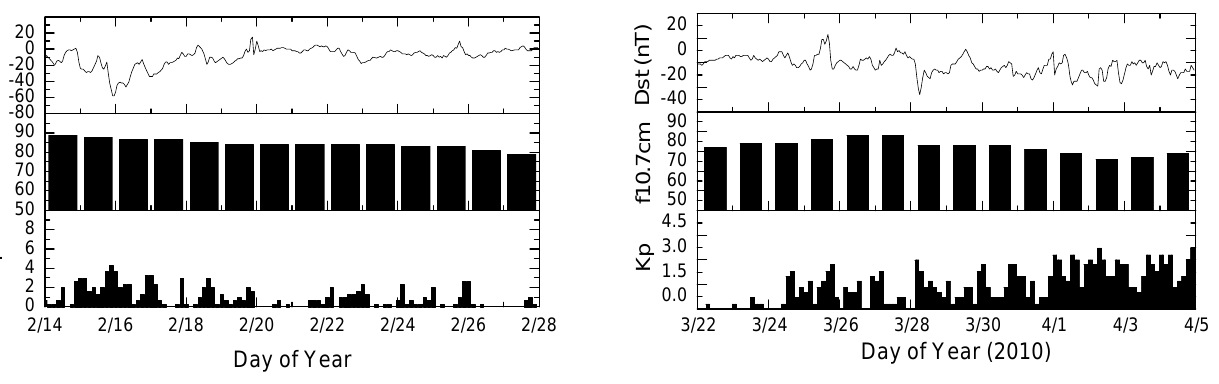
Fig. 7. Dst, F 10.7 , and K p indices during 22 March 2010 to 4 April 2010. Fig. 7. Dst, F 10 . 7 , and K p indices during 22 March 2010 to Fig. 5. Dst, F 10 . 7 , and K p indices during 14–27 February 2010. Fig. 5. Dst, F 10.7 , and K p indices during 14–27 February 2010.